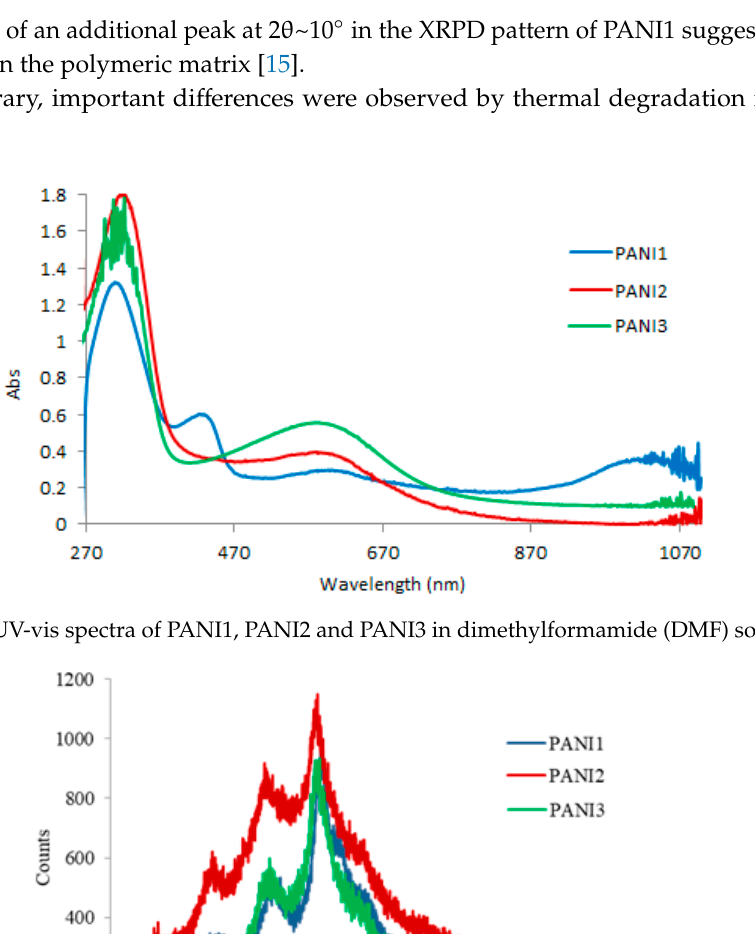
Figure 4. XRPD patterns of PANI1, PANI2 and PANI3.